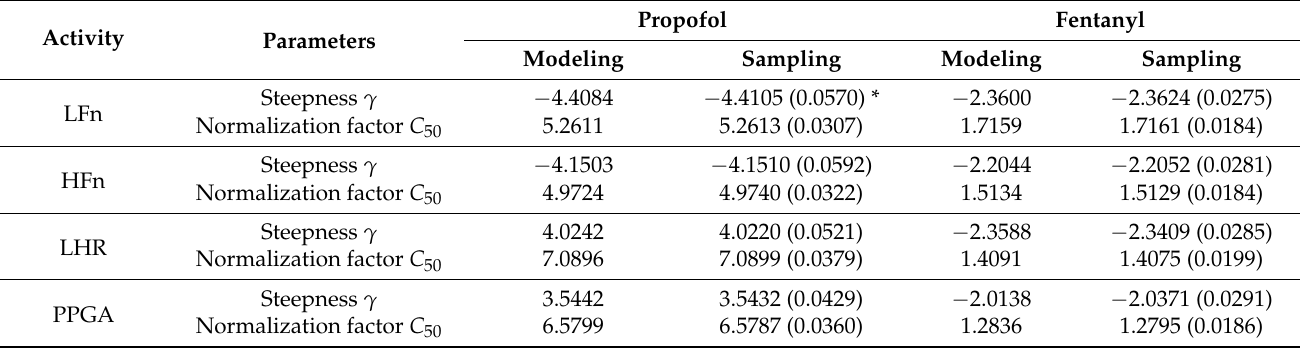
Figure 1. ( a , b ) The corresponding effects on the ANS caused by the effect-site concentrations of pure propofol (Cep) and fentanyl (Cef) in Groups 1 and 2, respectively. The black dots and red lines represent the raw data and the MLRSM predictions, respectively. Table 1. The modeling and sampling parameters of pure propofol and fentanyl MLRSM.